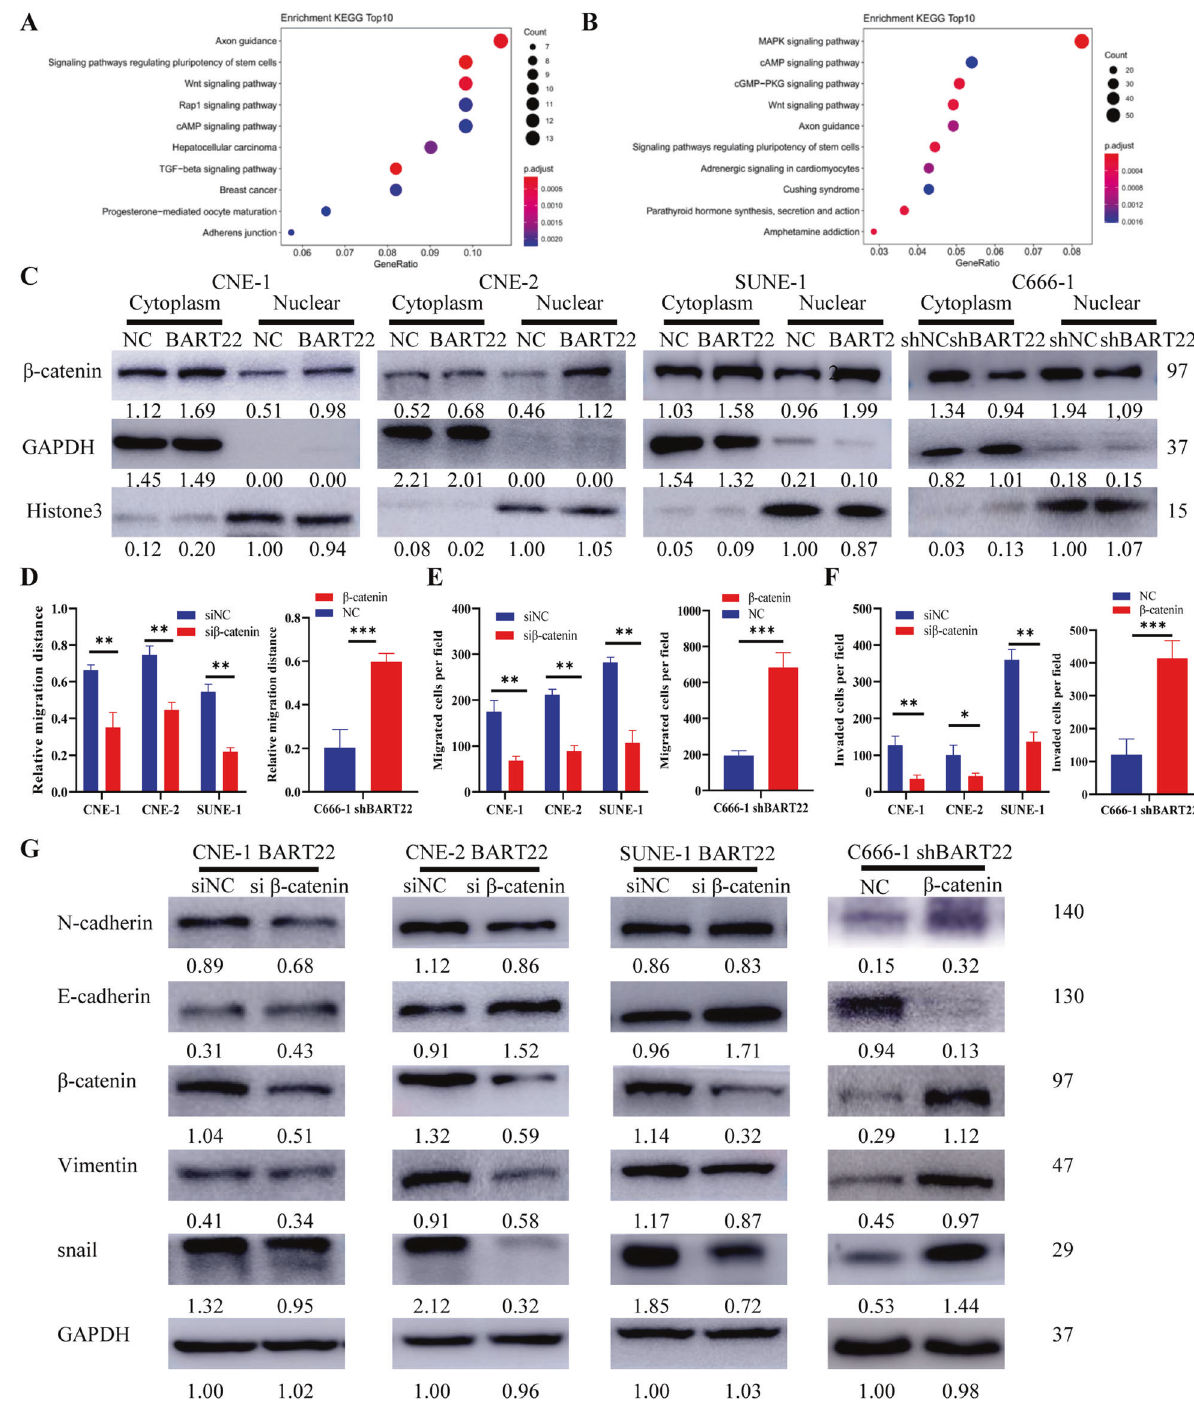
Fig. 6 EBV-miR-BART22 induces β -catenin abnormally activated in the NPC cell lines. A Pathway based on the KEGG and TargetScan databases. B Pathway based on the KEGG and DIANA databases. C The nuclear fraction of indicated cells was analyzed by WB analysis. D – F Cells were treated with β -catenin siRNA and plasmid β -catenin for 72 h, and then performed wound-healing assays and Transwell/ migration assay. * P < 0.05. ** P < 0.01. G Expression of epithelial cell marker, mesenchymal cell marker, and β -catenin in indicated cells were examined by WB analysis. GAPDH was used as a loading